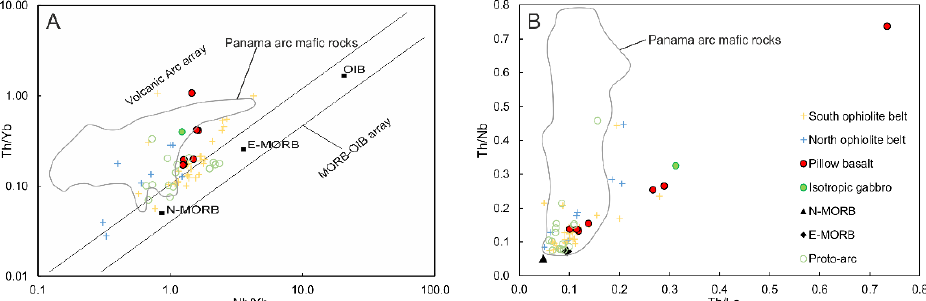
Figure 8. Tectonic discrimination for pillow basalts and the isotropic gabbro of ( A ) Nb/Yb vs Th/Yb and ( B ) Th/La vs Th/Yb. References for data are the same as Figure 4. The Panama arc mafic rocks are Chagres ‐ Bayano arc from [60] and only MgO > 4 wt.% are used.